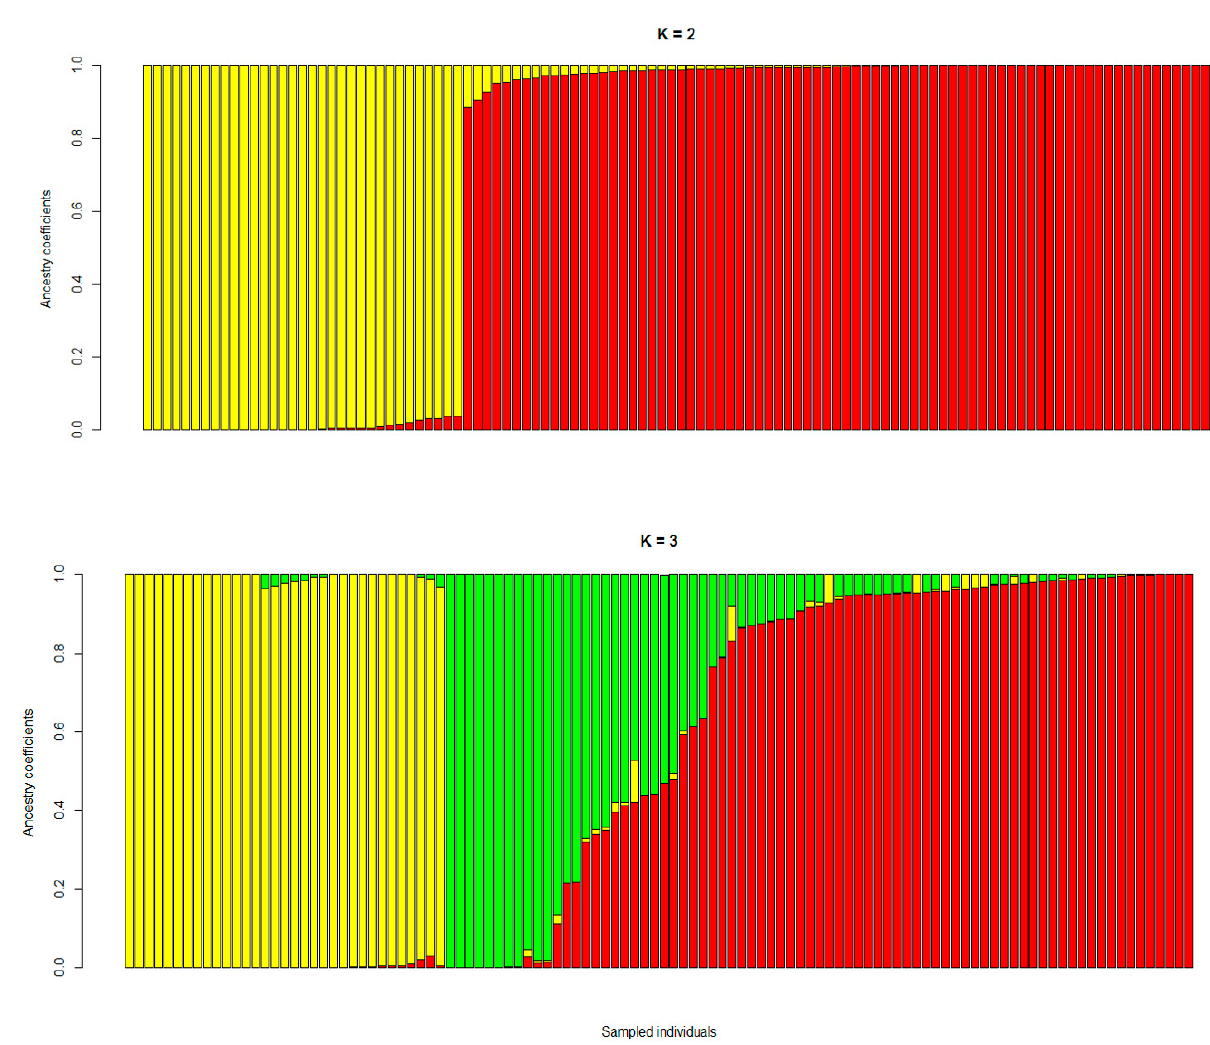
Figure 2. Bar plot for population structure of the 110 common bean accessions. Samples were sorted in the same order and classified conforming to successive selected K values from 2 to 10 subpopulations. The groups were identified for K = 2 and K = 3 .